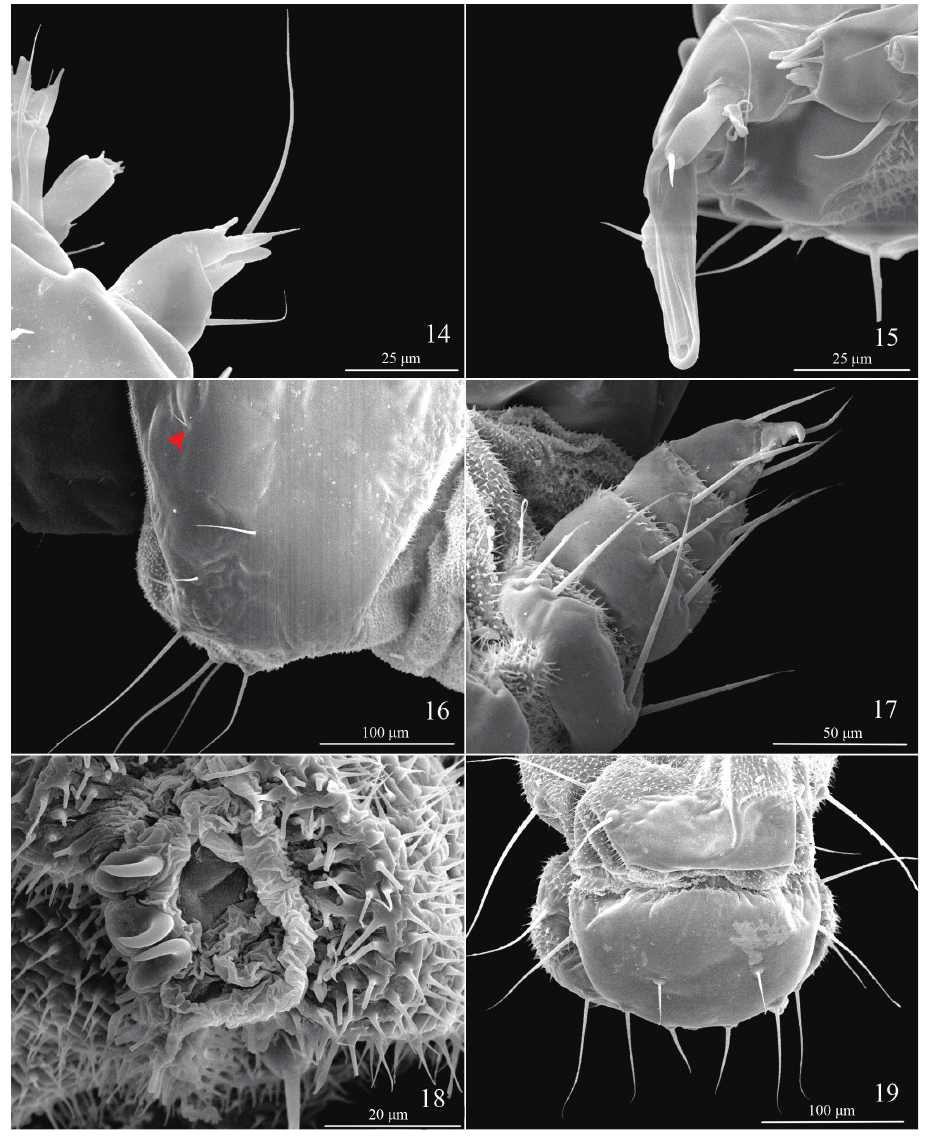
Figures 14−19. Last instar larval characters of Telamoptilia grewiae sp. n. 14 Antenna 15 Mouthpart 16 Setae on prothorax shield, arrow indicating the positon of XD1 17 Thoracic leg 18 Proleg 19 A9−10, dorsal